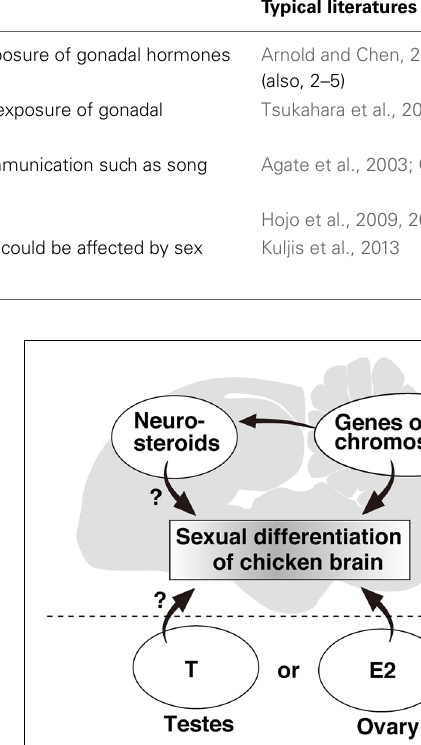
FIGURE 1 | Schematic diagram of the factors related to sexual differentiation of chicken